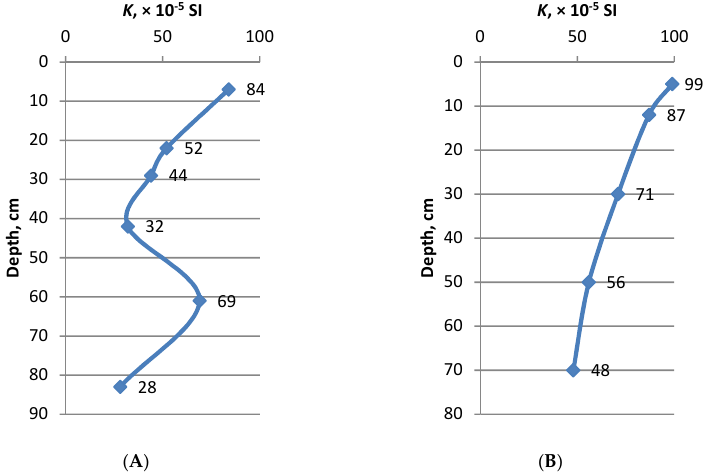
Figure 4. Intraprofile distribution of magnetic susceptibility in the soils of the city of Gubakha: ( A ) Urbic Technosol Loamic, Eutric; ( B ) Urbic Technosol Loamic, Skeletic. The average Κ value is 169 × 10 −5 SI for the soils of the roadside territories of the residential zone, and for the territory within the residential areas it is 120 × 10 −5 SI (Table 6). Table 6. Statistical parameters of the magnetic susceptibility of the upper soil horizons (0–10 cm) of the residential zone of Gubakha, ×10 −5 SI ( p = 0.05).